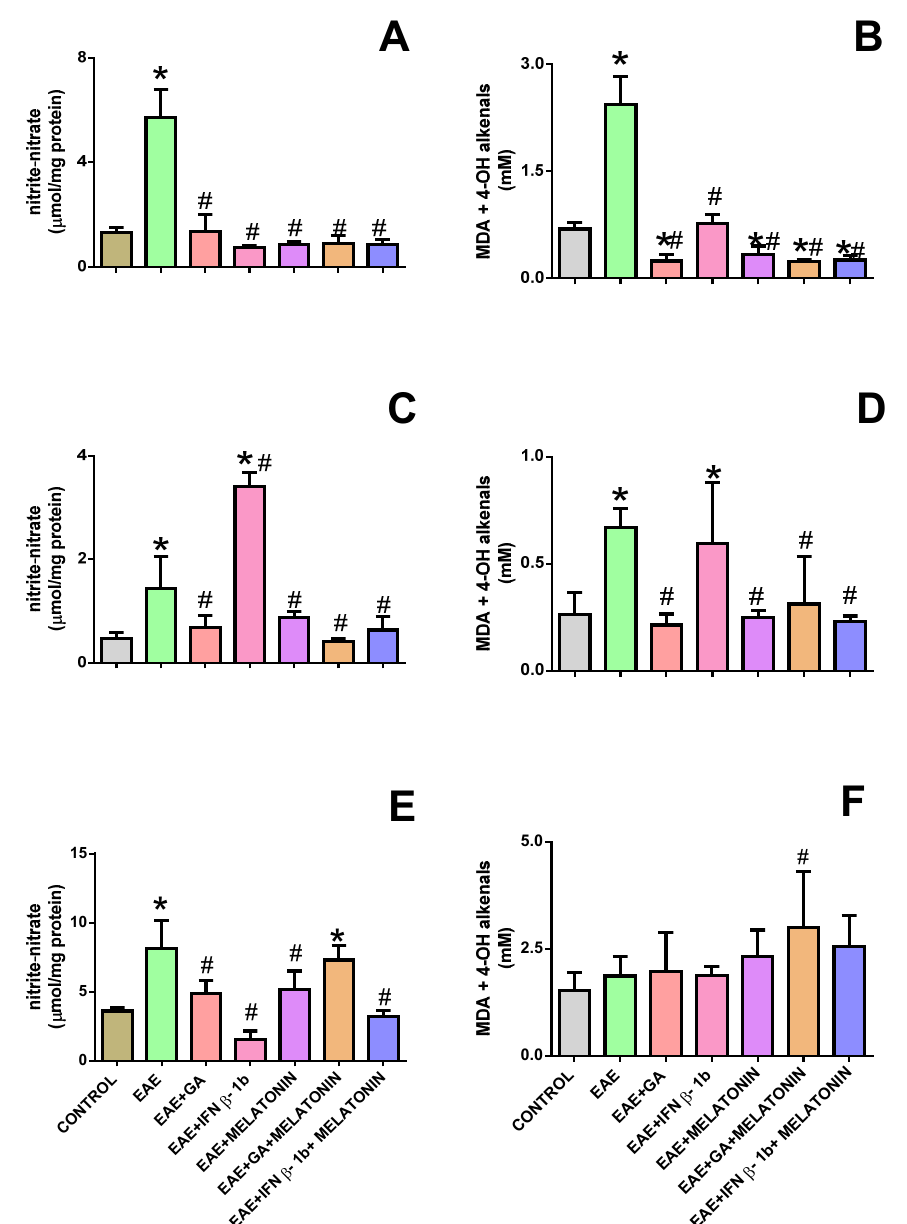
Figure 4. Levels of nitrite—nitrate ( A – C ) and end-products of lipid peroxidation ( D – F ) in the motor cortex ( A , D ), midbrain ( B , E ), and medulla homogenates from rats subjected to the indicated treatments. * indicates a significant difference from the control group ( p < 0.05); # indicates a significant difference from the EAE group ( p < 0.05).